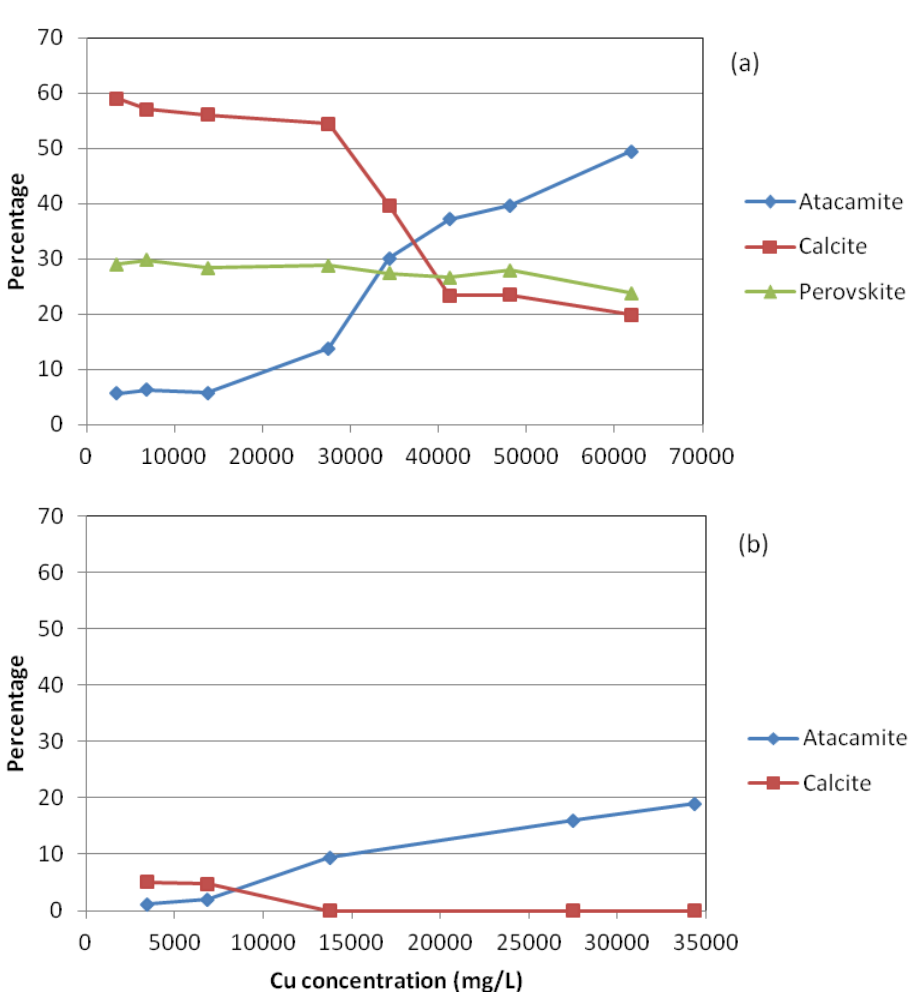
Figure 2. Changes in the abundance of Ca- and Cu-bearing minerals with increasing Cu dose for ( a ) GR and ( b )